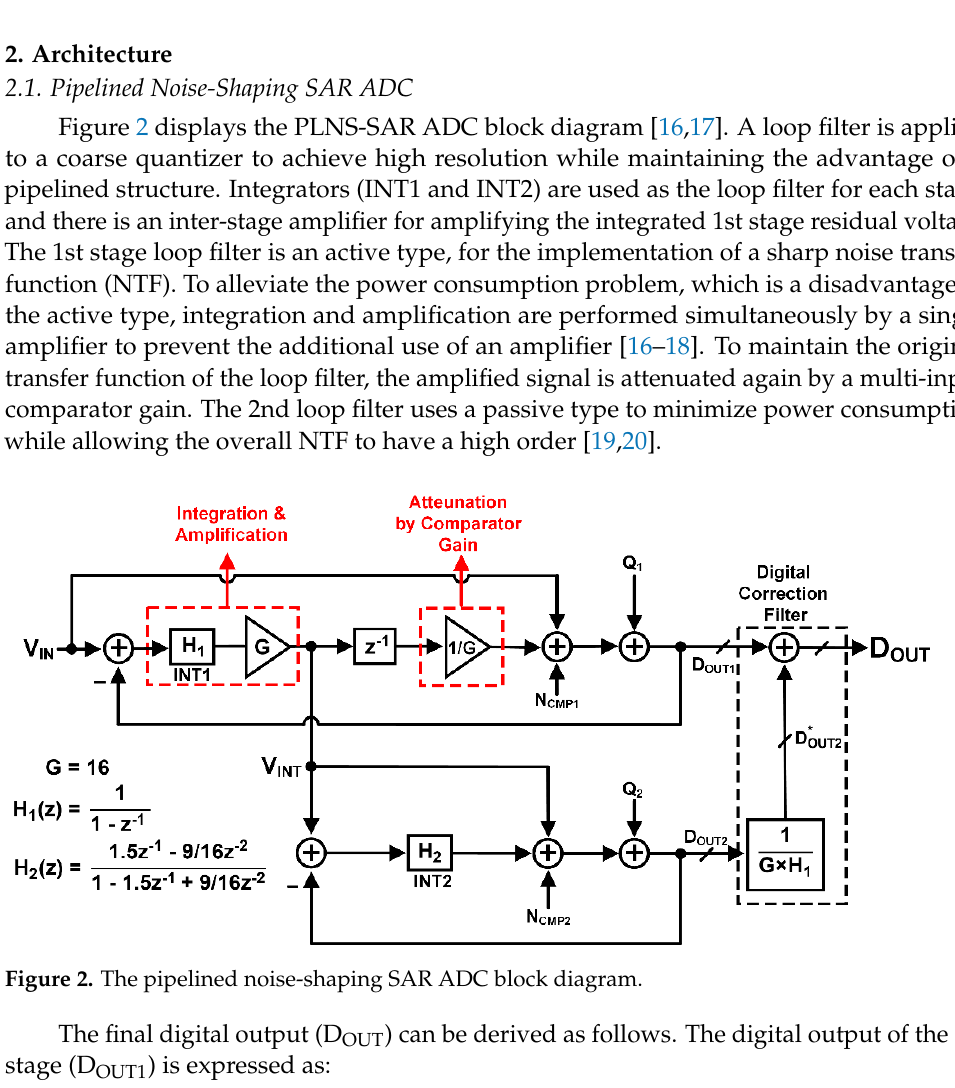
( b ) Figure 3. The SQNR histogram for different open-loop gain of inter-stage amplifier with 5% variation and no filter cali- bration: ( a ) the open-loop gain of 40 dB and ( b ) the open-loop gain of 60 dB. 2.2. Ring Amplifier An op-amp/operational trans-conductance amplifier (OTA) with a high open-loop gain is used in most pipelined structures because of its tolerance to filter mismatch. Among the various structures available, a gain-boosting, cascode-type op-amp is often used conventionally, as shown in Figure 4a [7,13,22,23]. However, it accounts for most of